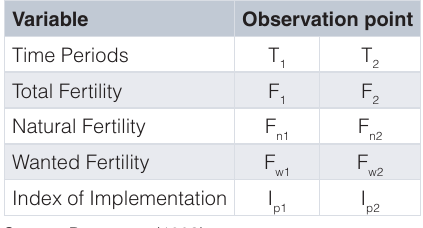
Table 2. Fertility